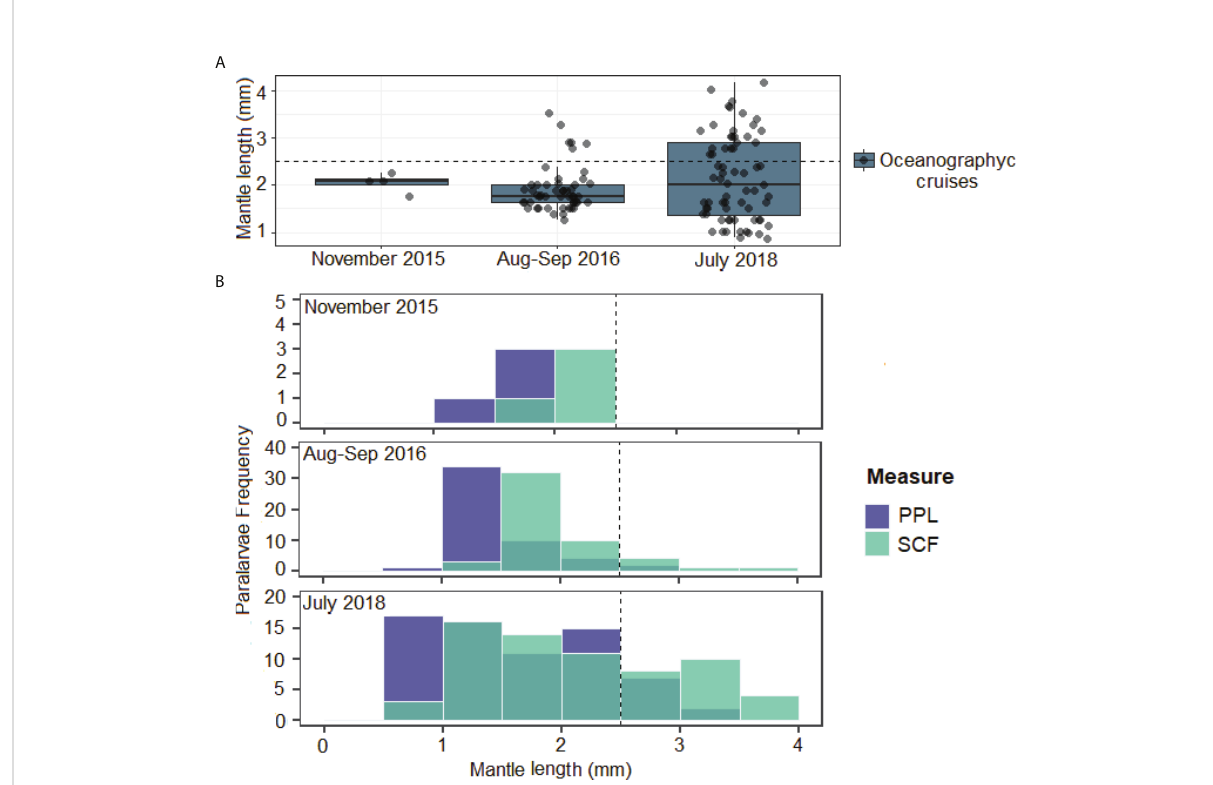
FIGURE 4 Loliginidae paralarvae. (A) Mantle length (ML) data dispersion by cruise carried out at the southeastern Gulf of Mexico. (B) Size structure of paralarvae during November 2015, August-September 2016, and July 2018. Frequency of preserved paralarvae (PPL) and frequency of fresh specimens were calculated with the shrinkage correction factor (SCF). The percentage of newly hatched organisms (<2.5 mm ML) with the SCF is